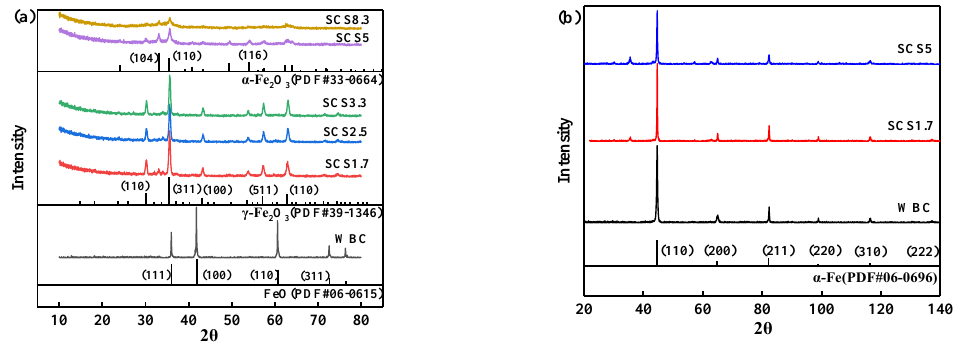
Figure 1. XRD patterns of SCS and WBC catalysts ( a ) fresh catalysts and ( b ) reduced catalysts.